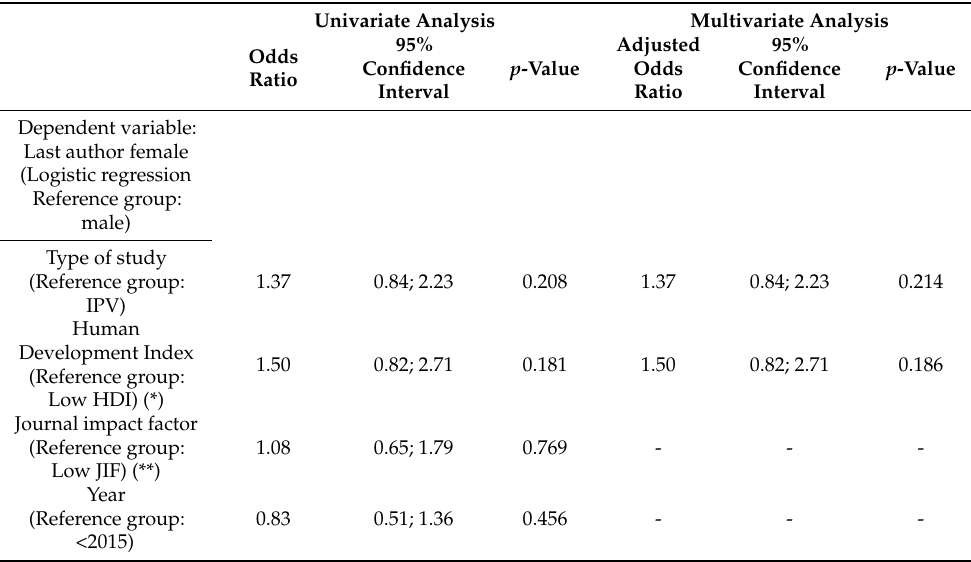
Table 4. Multivariate regression estimates of last author gender among prevalence studies of in- timate partner violence (IPV) during pregnancy and prevalence of gestational diabetes mellitus (GDM) included.